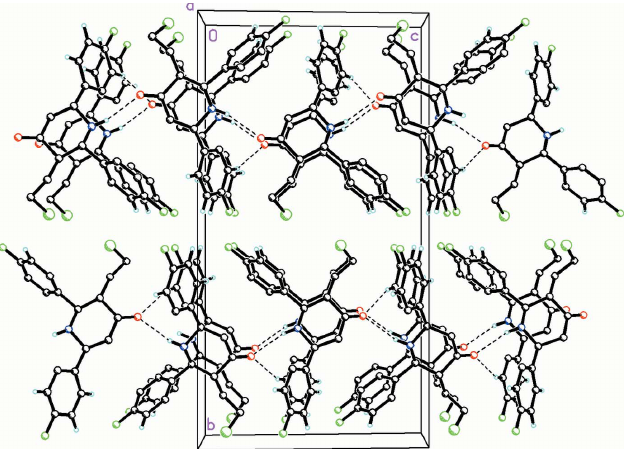
Figure 4 A partial view along the a axis of the crystal packing for (II), showing infinite chains formed along [001] by weak N1—H1 (cid:3)(cid:3)(cid:3) O1 and C12— H12 (cid:3)(cid:3)(cid:3) O1 hydrogen-bonding interactions. The keto oxygen, O1, forms a weak hydrogen bond with N1 from a piperdine ring in the same plane and with C12 from one of the diaryl groups of a molecule in an adjacent plane along the a axis. H atoms not involved in these interactions have been omitted for clarity.